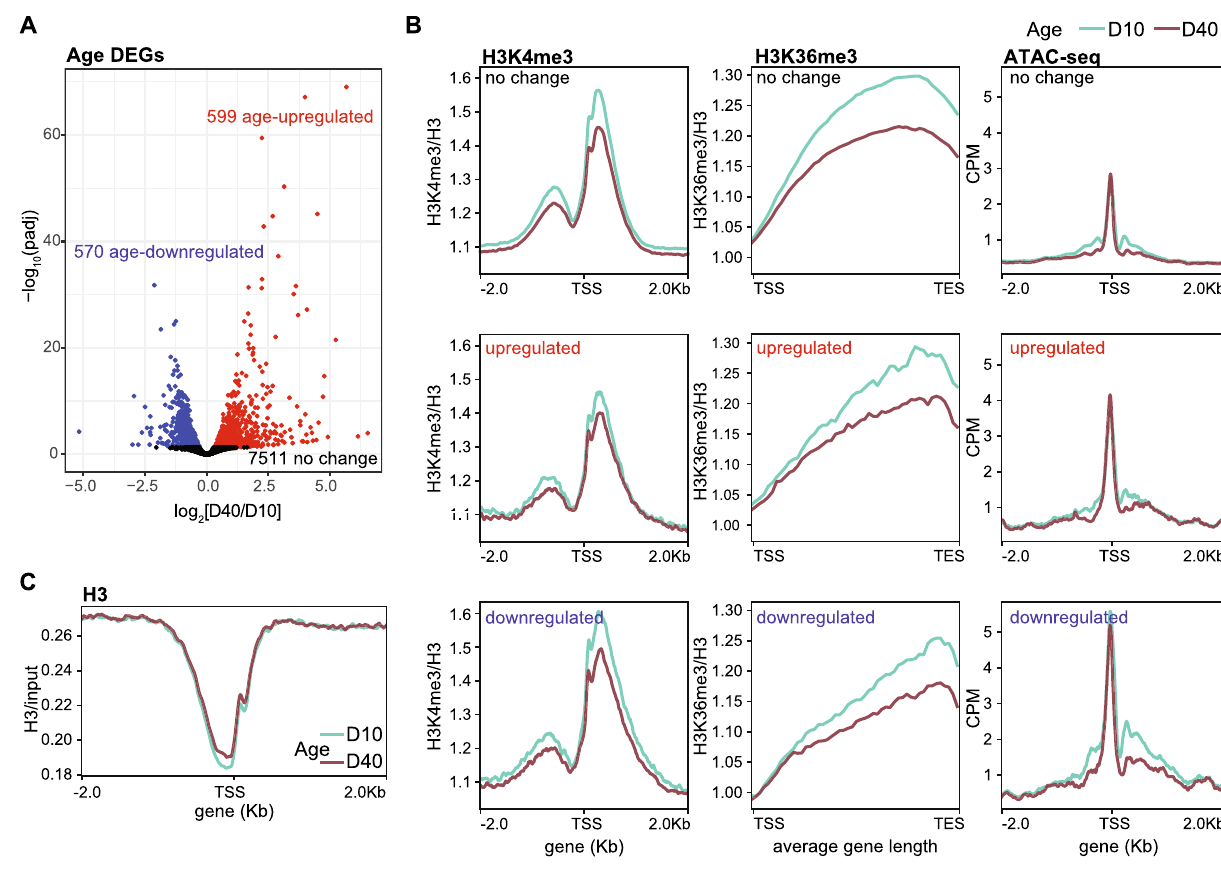
Figure 2. Actively expressed genes have decreased active histone methyl marks independent of their transcriptional status. ( A ) Volcano plot showing genes that were differentially expressed between D10 and D40 in photoreceptors. ( B ) Gene metaplots showing average H3-normalized H3K4me3 and H3K36me3 levels and ATAC-seq signal around the TSS (H3K4me3 and ATAC-seq) or over gene bodies (H3K36me3) at D10 and D40 for genes classified based on their differentially expression status with age as described in panel ( A ). ( C ) Gene metaplot of average chromatin input-normalized H3 signal (n = 4) for actively expressed genes with signal centered around the